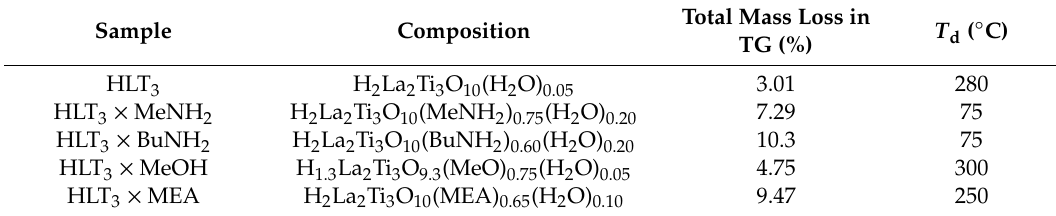
Table 2. The composition and decomposition temperature ( T d ) for the studied compounds. TG: thermal gravimetric.